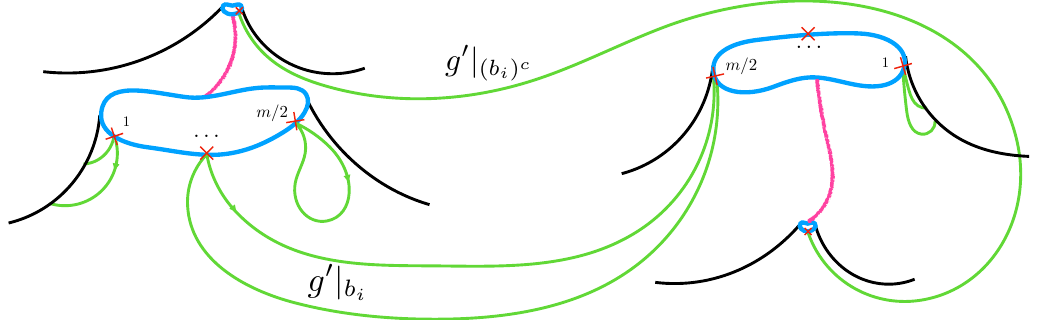
Figure 27 . The surface Σ X is constructed from Σ A in such away that we can insert non-crossing curves on Σ , shown in pink. These curves pass between the two boundaries associated to the X blocks in t . We can use these curves and some other non-crossing curves, labelled g 0 | A between the two boundaries associated to the block b